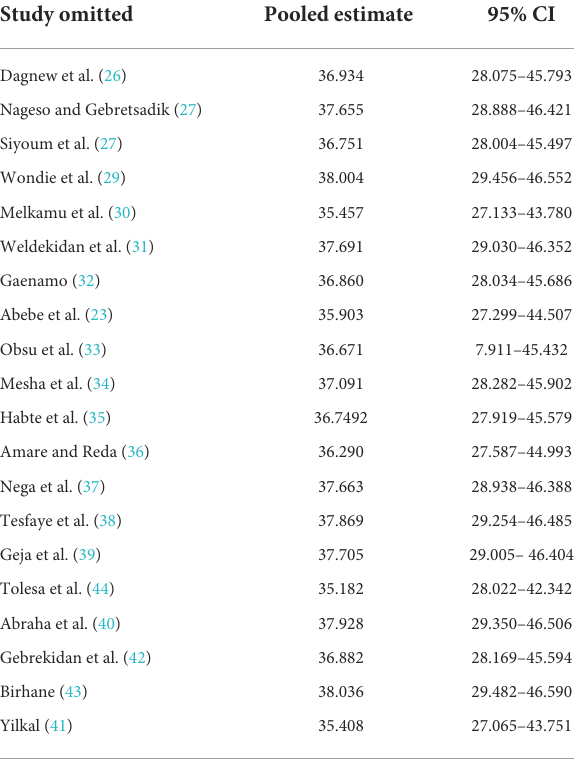
TABLE 3 The pooled prevalence of discontinuation of long acting reversible contraceptives in Ethiopia when one study omitted from the analysis a step at a time 2022.